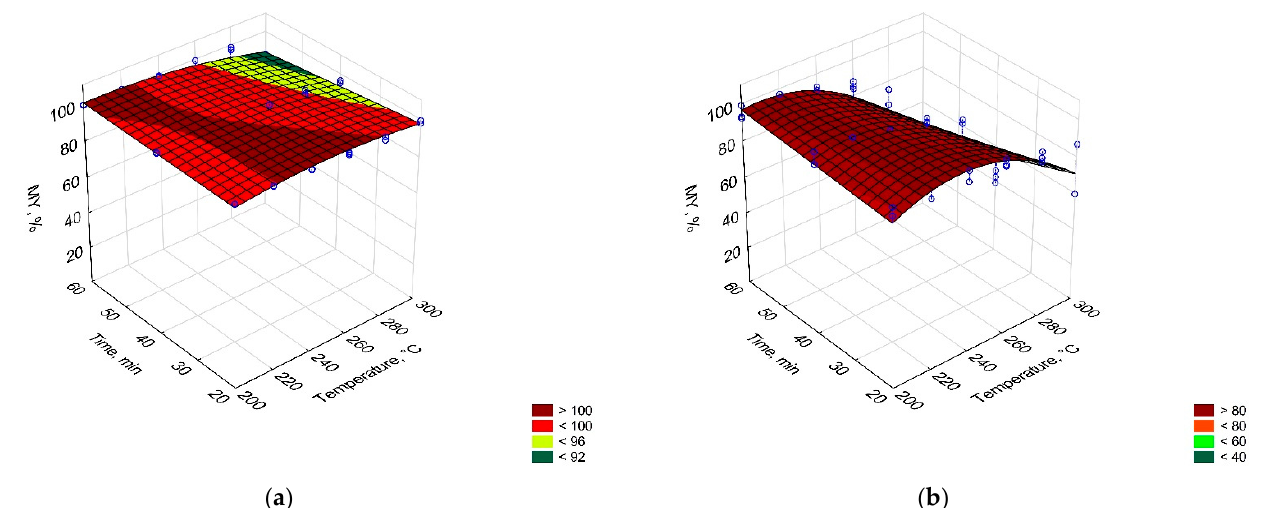
Materials 2021 , 14 , x FOR PEER REVIEW Figure 2. Temperature and time effect on the mass yield (MY) of carbonized solid fuel made from ( a ) PLA, ( b ) PAP.